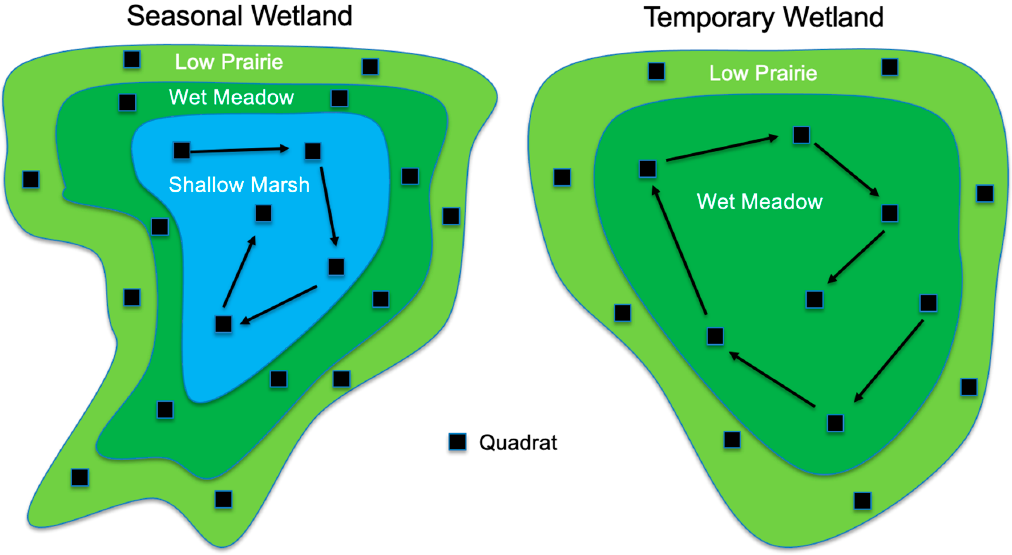
Figure 4. Example quadrat layouts by vegetation zone for seasonal and temporary